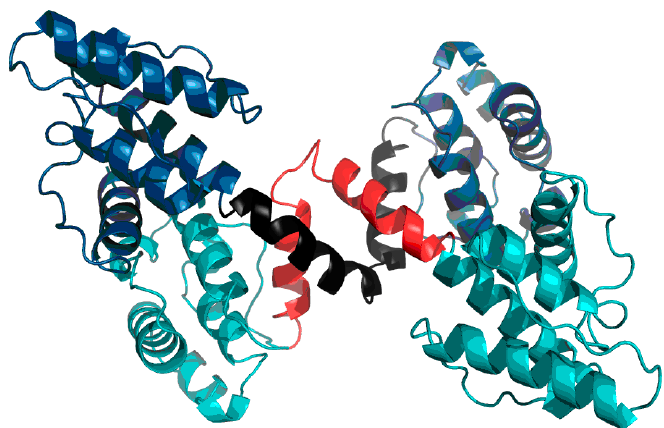
Figure 12. Utrophin homodimer (chain A: Dark blue; chain B: Teal). Fragments contributed to the domain interface by chains A and B are marked in black and red respectively.